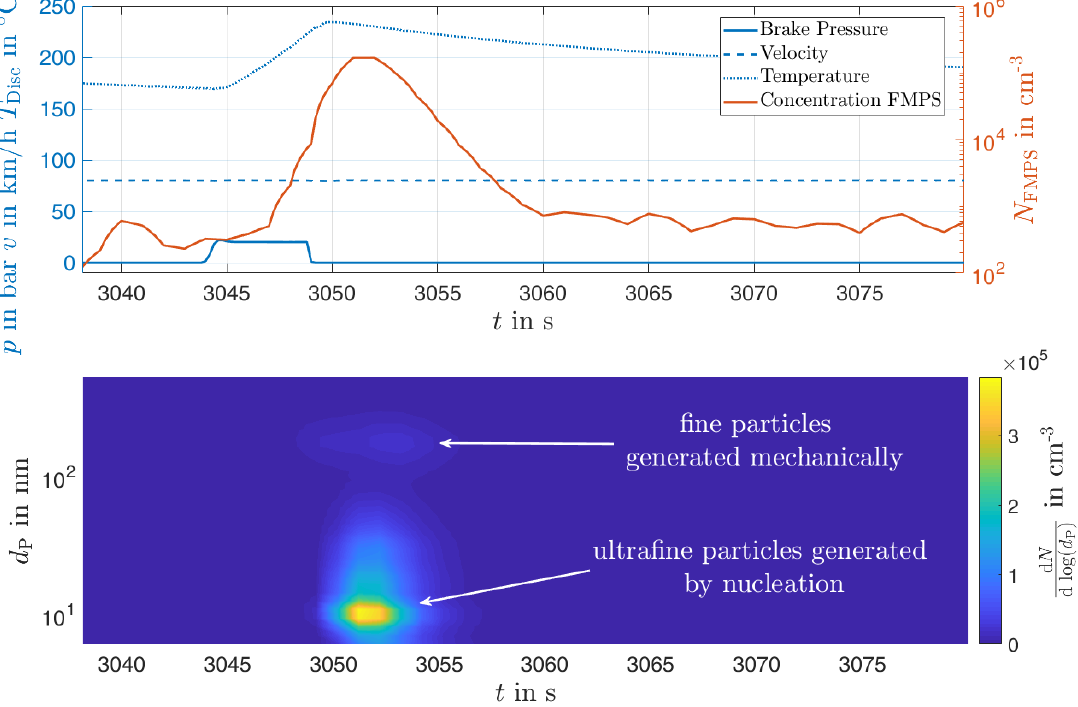
Figure 1. Time series of the concentration N measured by a Fast Mobility Particle Sizer (FMPS) during a nucleation event caused by a drag braking test ( p : brake pressure, v : Vehicle speed, T : temperature) and time series of the size distribution measured by the FMPS (below). Although the FMPS also detects mechanically generated particles (peak at 200 nm) the major part of PM 10 emissions is generated by particles with a diameter of 2 µm, as it was shown by Asbach et al. [3].